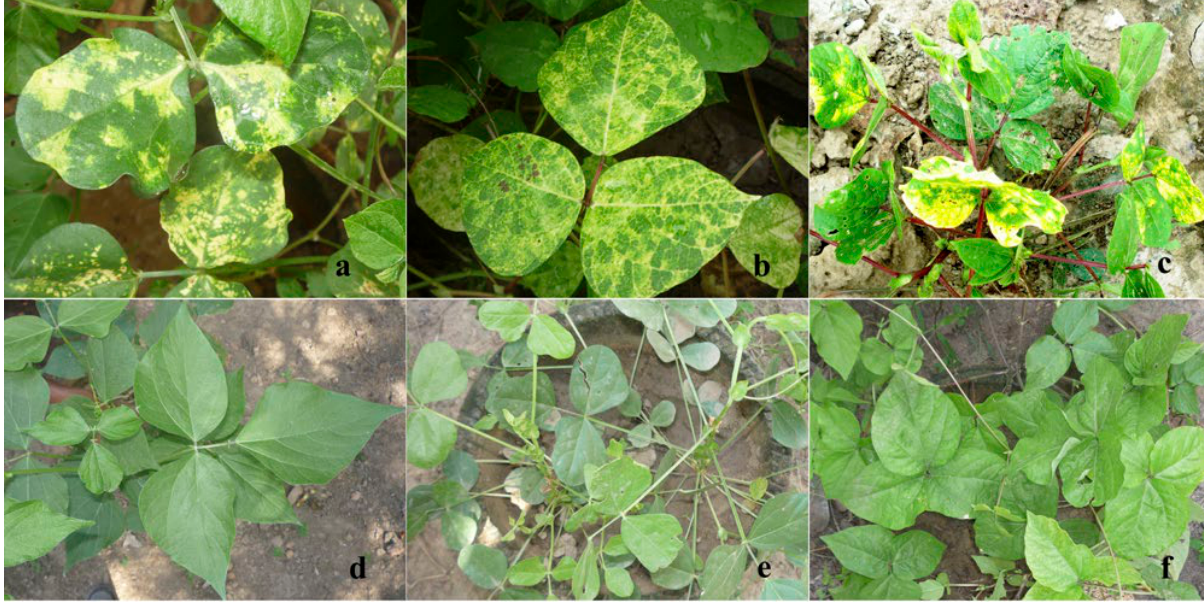
Figure 1. Wild Vigna species showing yellow mosaic disease symptoms on a) Vigna trilobata ; b and c) V. trinervia var. bourne- ae and resistant reaction on d) Vigna synthetic allotetraploid; e) V. trilobata ; and f) V. mungo var . sylvestris